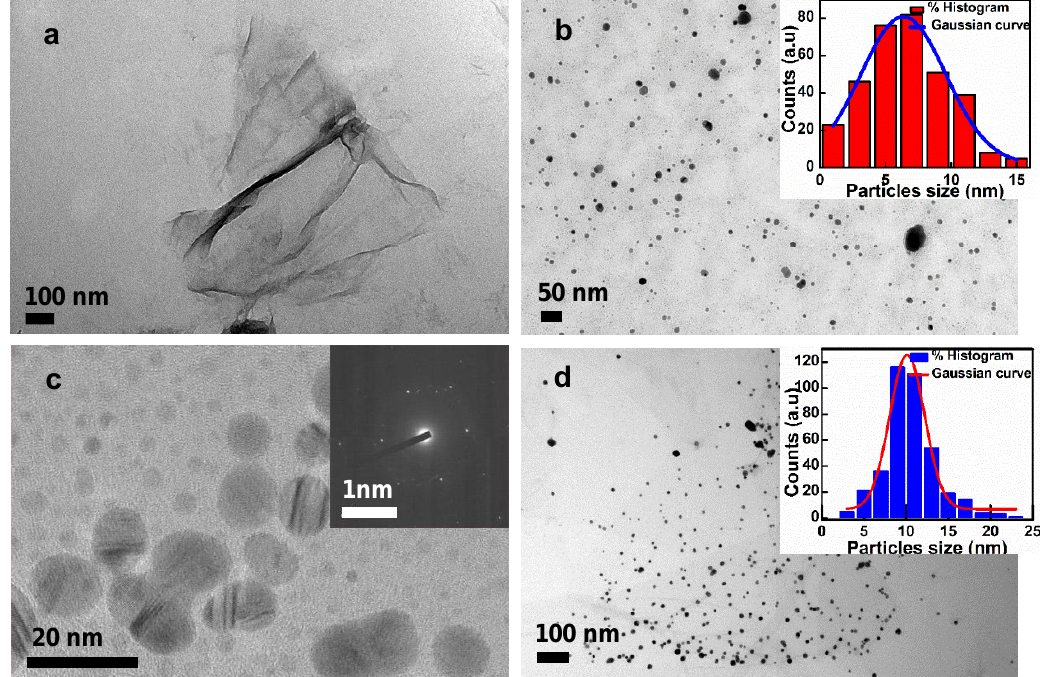
Figure 1. TEM images of GO ( a ), Ag NPs along with the its particle size distribution ( b ), HRTEM image of Ag NPs at 500 kV with electron diffraction ( c ), and TEM image of GO–Ag NPs with Ag particle size distribution ( d ). Size distribution analysis was analyzed using ImageJ software. (IJ152-NIH Image,